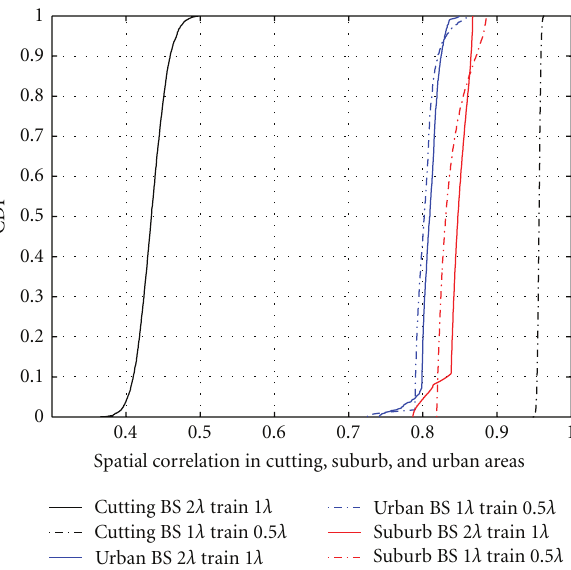
Figure 7: The CDF curves for the three